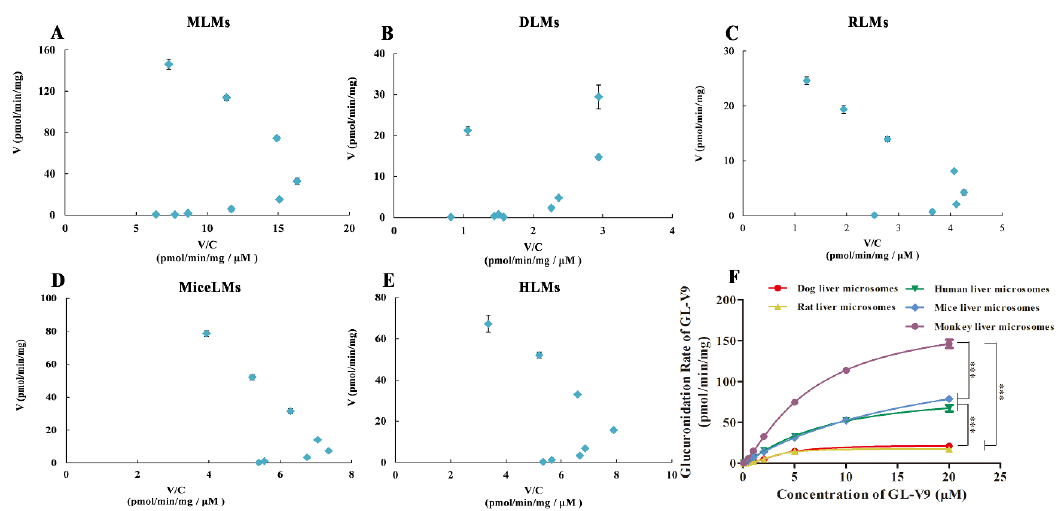
Figure 5. Eadie-Hofstee plots for the formation of 5-O-glucuronide GL-V9 by MLMs ( A ), DLMs ( B ), RLMs ( C ), MiceLMs ( D ), HLMs ( E ), and enzyme kinetics comparisons between these liver microsomes ( F ). Serial concentrations of GL-V9 were incubated with liver microsomes from five different species (monkey, beagle dog, rat, mouse, and human). Glucuronides of GL-V9 in incubation system were quantified using UPLC-MS/MS. The formation rates were calculated and described as pmol/min/mg protein. Kinetic profiles were fitted into Eadie-Hofstee plots to determine enzyme-mediated reaction types. All the data were expressed as the average of three determinations and the error bar represents the standard deviation of the mean (mean ± SD, n = 3). *** p < 0.001 indicating significantly different. Table 1. Enzyme kinetic parameters of GL-V9 in MLMs, DLMs, RLMs, MiceLMs, HLMs incubation systems (mean ± SD, n = 3).